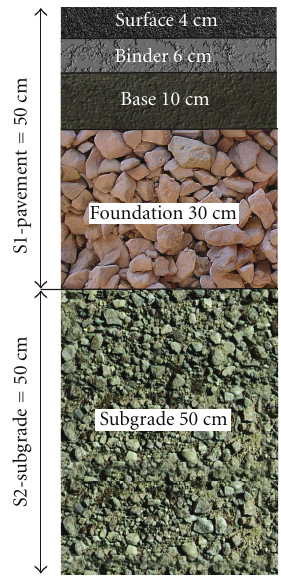
Figure 2: Scheme of the investigated road section.